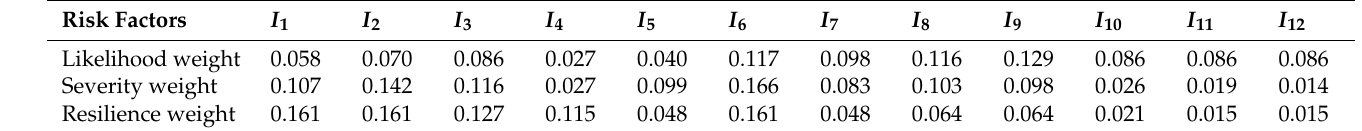
Table 13. Risk factors’ weights derived for expert E 1 .